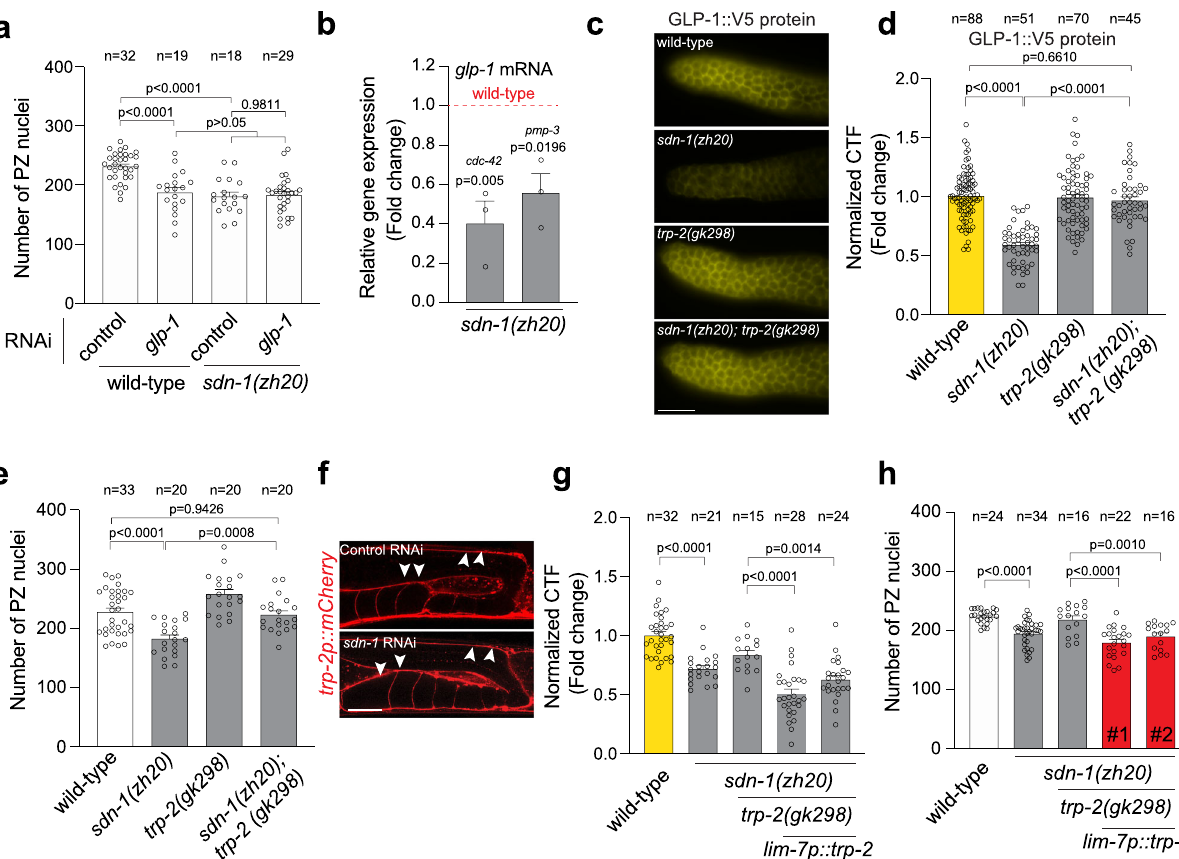
Fig. 2 SDN-1 promotes GLP-1/Notch expression to control mitotic germ cell fate. a Quanti fi cation of PZ nuclei in wild-type and sdn-1(zh20) adult hermaphrodites grown on control (L4440 vector) and glp-1 RNAi bacteria. Data were expressed as mean ± s.e.m. and statistical signi fi cance was assessed by ordinary one-way ANOVA. b Quanti fi cation of glp-1 mRNA by qPCR in sdn-1(zh20) animals compared to wild-type. Two independent reference genes ( cdc-42 ) and ( pmp-3 ) were used to normalize expression. RNA was isolated from dissected germlines. Data were expressed as mean ± s.e.m. and statistical signi fi cance was assessed by ordinary one-way ANOVA. independent biological triplicate RNA samples for each genotype. c , d Immuno fl uorescence images ( c ) and quanti fi cation ( d ) of GLP-1::V5 expression in the PZ of wild-type, sdn-1(zh20) , trp-2(gk298) , and sdn-1(zh20); trp-2(gk298) adult hermaphrodites. Data were expressed as mean ± s.e.m. and statistical signi fi cance was assessed by ordinary one-way ANOVA. Scale bar = 10 µ m. e Quanti fi cation of PZ nuclei in wild-type, sdn-1(zh20) , trp-2(gk298) , and sdn-1(zh20); trp-2(gk298) adult hermaphrodites. Data were expressed as mean ± s.e.m. and statistical signi fi cance was assessed by ordinary one-way ANOVA. f Fluorescence images of trp-2p::mCherry in the gonadal sheath (white arrowheads) in control (upper image) and sdn-1 RNAi (lower image) adult hermaphrodites. Twenty germlines were examined in duplicate. Scale bar 20 µ m. g , h Quanti fi cation of GLP-1::V5 expression in the PZ ( g ) and PZ nuclei number ( h ) of wild-type, sdn-1(zh20) , and sdn-1(zh20); trp-2(gk298) (± lim- 7p::trp-2 cDNA ) adult hermaphrodites. Data were expressed as mean ± s.e.m. and statistical signi fi cance was assessed by ordinary one-way ANOVA. For all panels, n refers to the number of animals analyzed. P values as indicated. Source data are provided as a Source Data fi